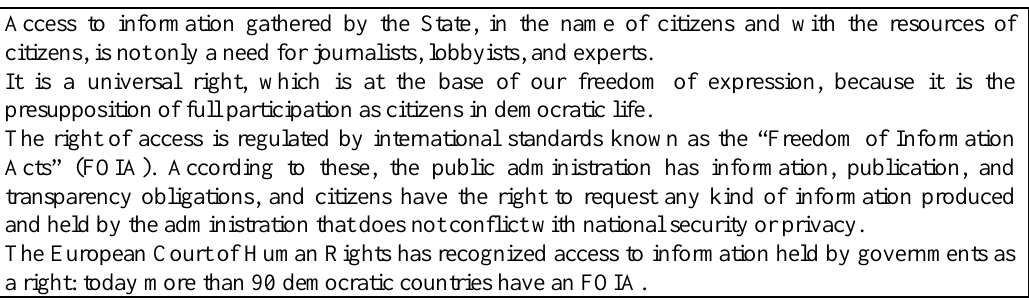
Table 4: Freedom of Information Act